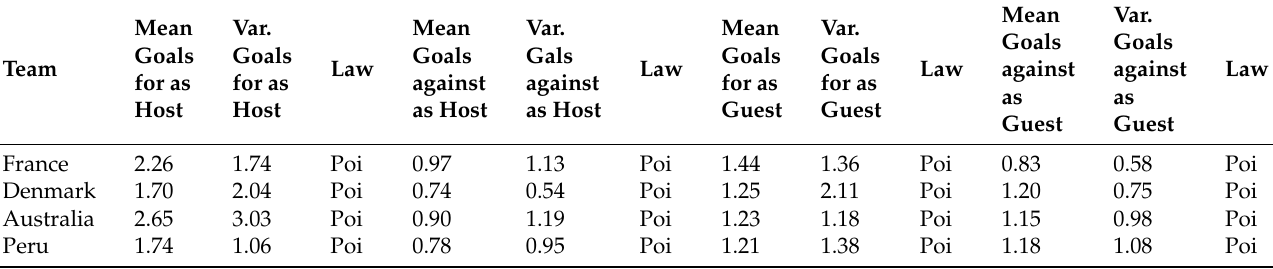
Table 8. Group C in Russia 2018.